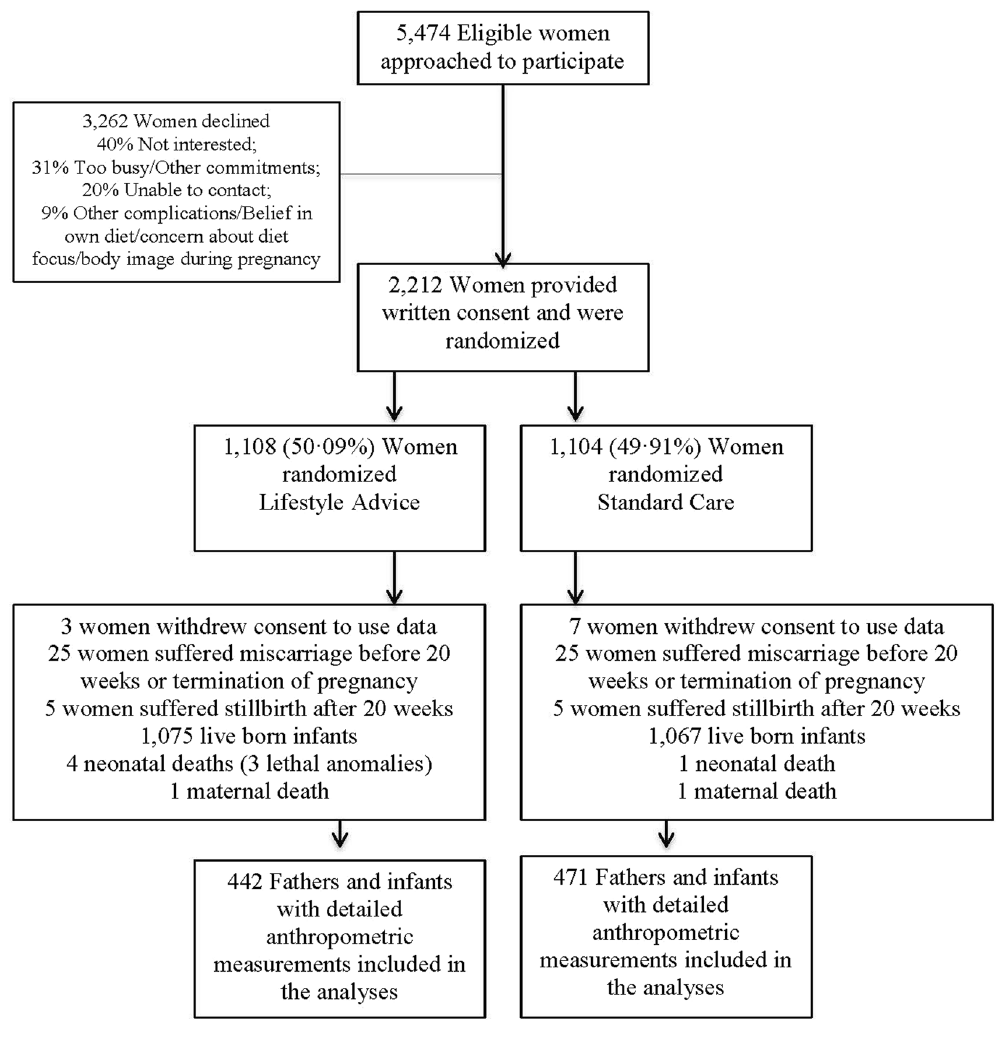
Figure 1. Flow of participants through the